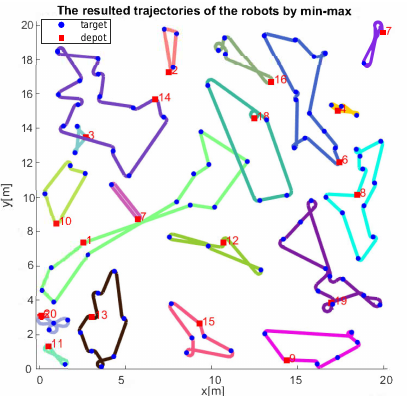
Figure 3. A solution derived by the proposed heuristic for 20 robots with 100 tasks. The numbers next to the depots represent the index of the robots, and the colored path connected to each depot is the trajectory of the corresponding robots. The computation time is 1567 s, which is around 26